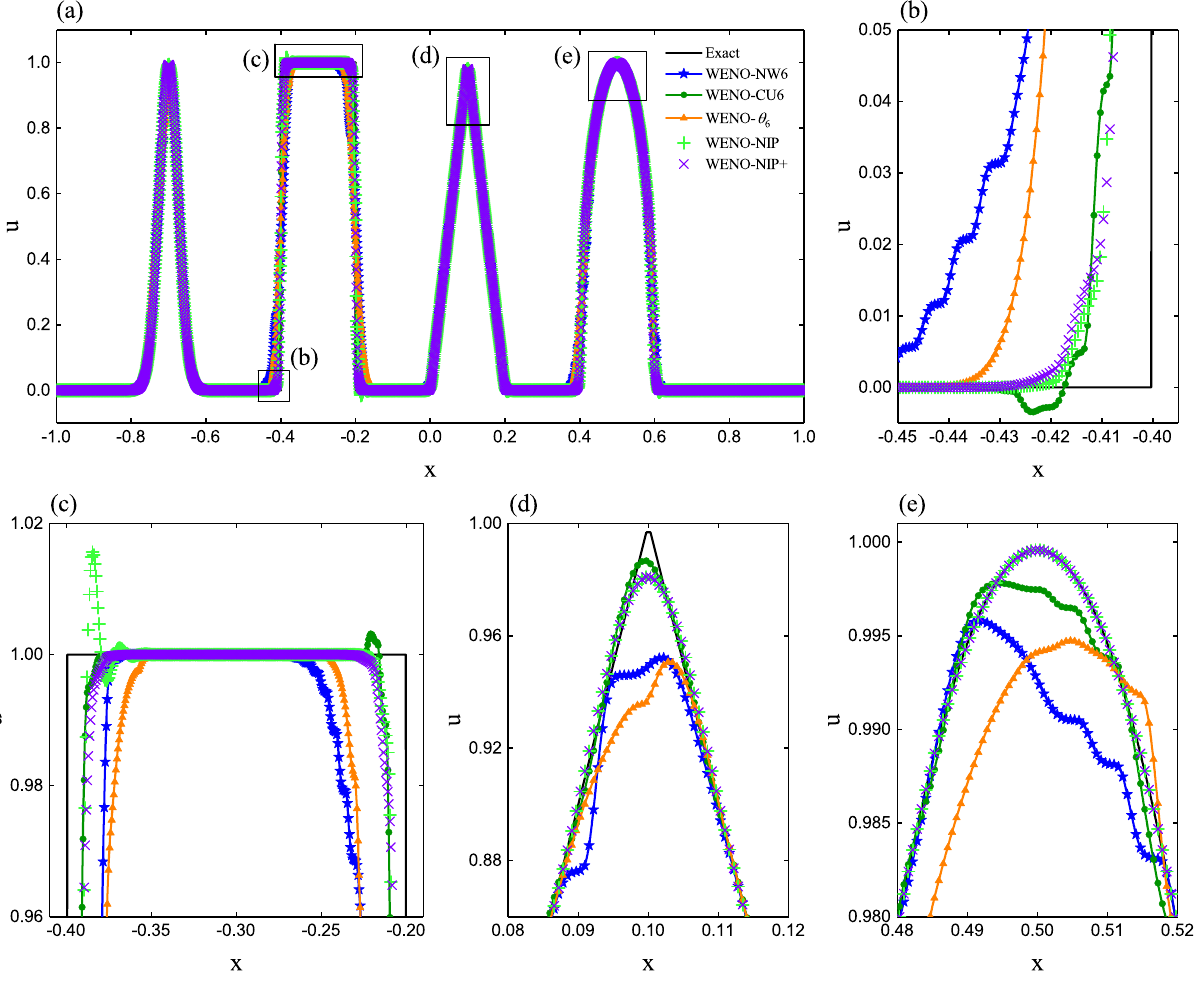
Figure 10. ( a ) Results of the Gaussian-square-triangle-ellipse linear test (see Example 1) computed by the WENO-NW6, WENO-CU6, WENO- θ 6, WENO-NIP, and WENO-NIP+ schemes with t = 200 and N = 3200. ( b ) Zoomed in view of the left bottom of the square wave. ( c ) Zoomed in view of the top of the square wave. ( d ) Zoomed in view of the top of the triangle wave. ( e ) Zoomed in view of the top of the ellipse